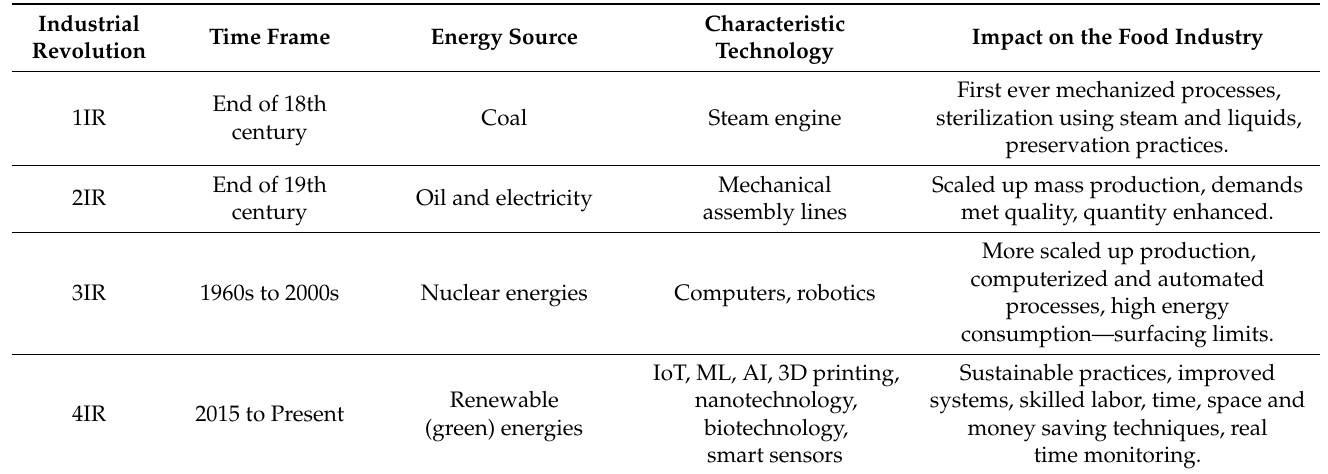
Table 1. Industrial revolutions, their characteristics, and their impact on food